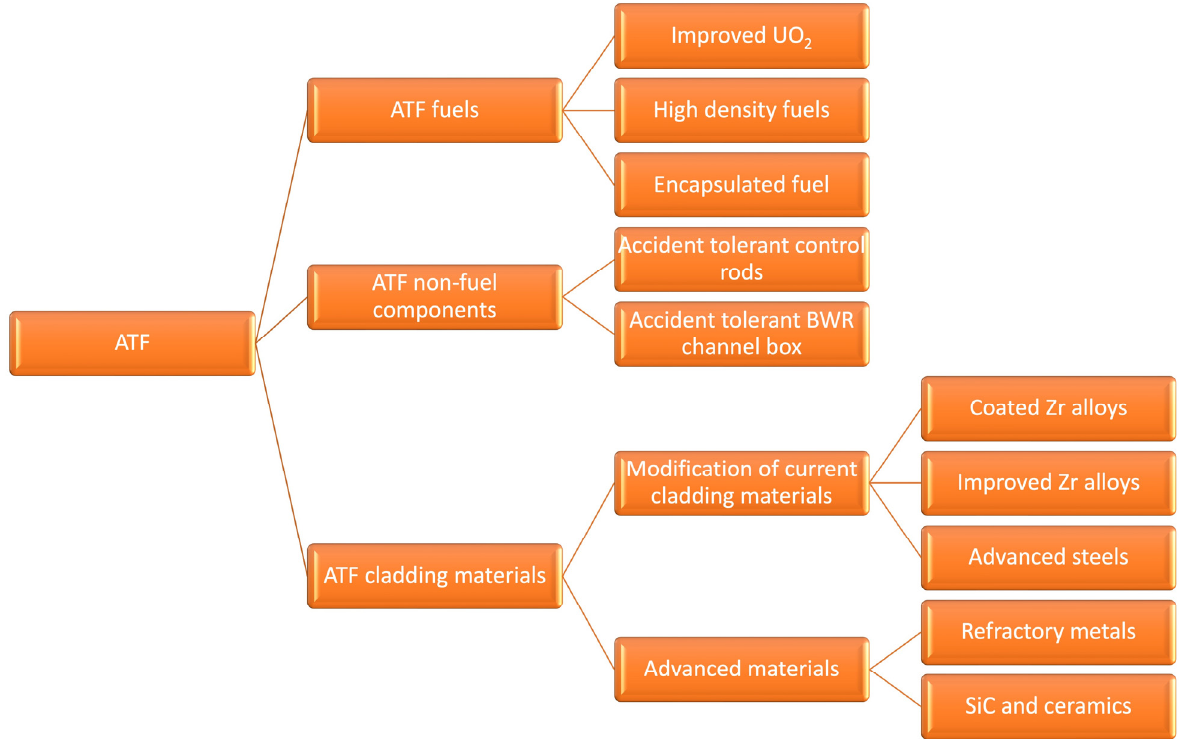
Figure 1. Introducing materials in the ATF concept.